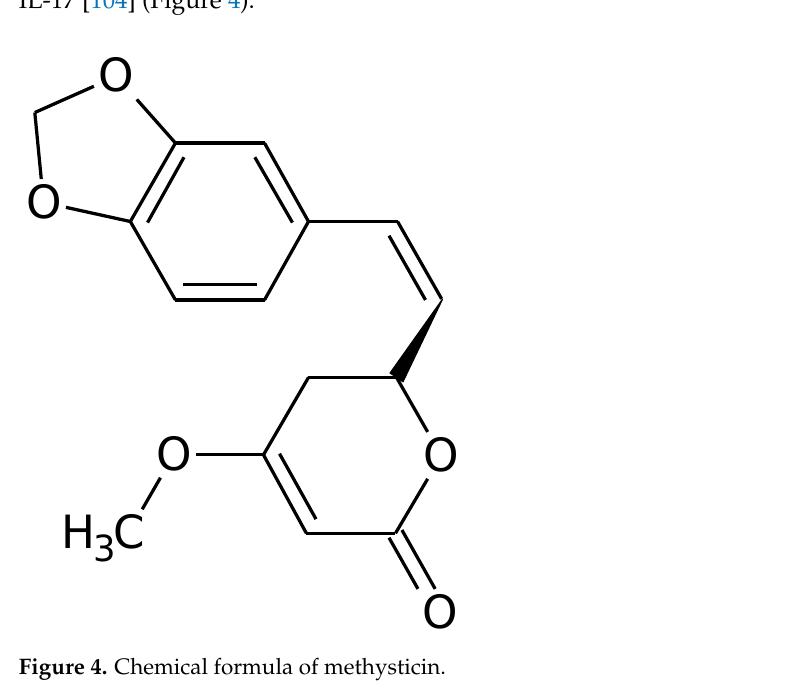
(c) Figure 5. Chemical formula of ( a ) sulforaphane, ( b ) allicin and ( c ) [(4- tert -butylcyclohexylidene)me- thyl] (4-methoxystyryl)sulfide (BMMS). Allicin (Figure 5b), which is obtained from fresh garlic extract, improved endoplas- mic reticulum (ER) stress-related cognitive impairments by increasing double-stranded RNA-dependent protein kinase (PKR)-like ER-resident kinase (PERK)/Nrf2 pathway in the hippocampus of AD rat model treated with tunicamycin, an ER stress stimulator [107]. One of the alternative treatments for AD includes organochalcogens. The preventive effect of [(4- tert -butylcyclohexylidene)methyl] (4-methoxystyryl)sulfide (BMMS) (Figure 5c) was demonstrated in an AD mouse model induced by scopolamine treatment. The data obtained in this study showed that BMMS pretreatment was able to prevent OS levels